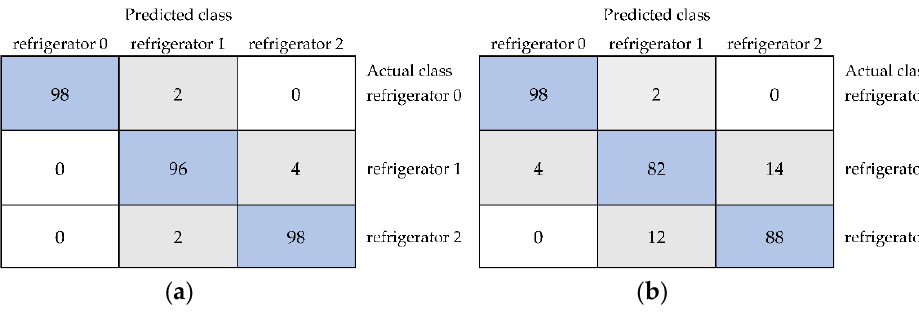
Figure 7. The confusion matrices of the classification of unstored black currants (refrigerator 0) and fruit stored in the refrigerator for 1 week (refrigerator 1) and 2 weeks (refrigerator 2) using models including selected image textures from color space XYZ built using random forest ( a ) and multiclass classifier ( b ).